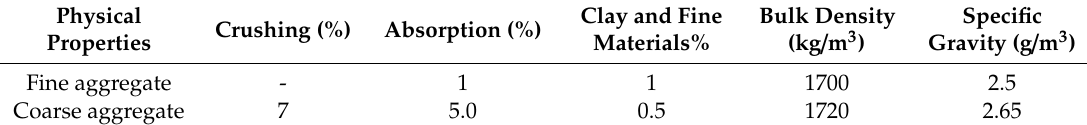
Table 2. Physical properties of the used aggregates.